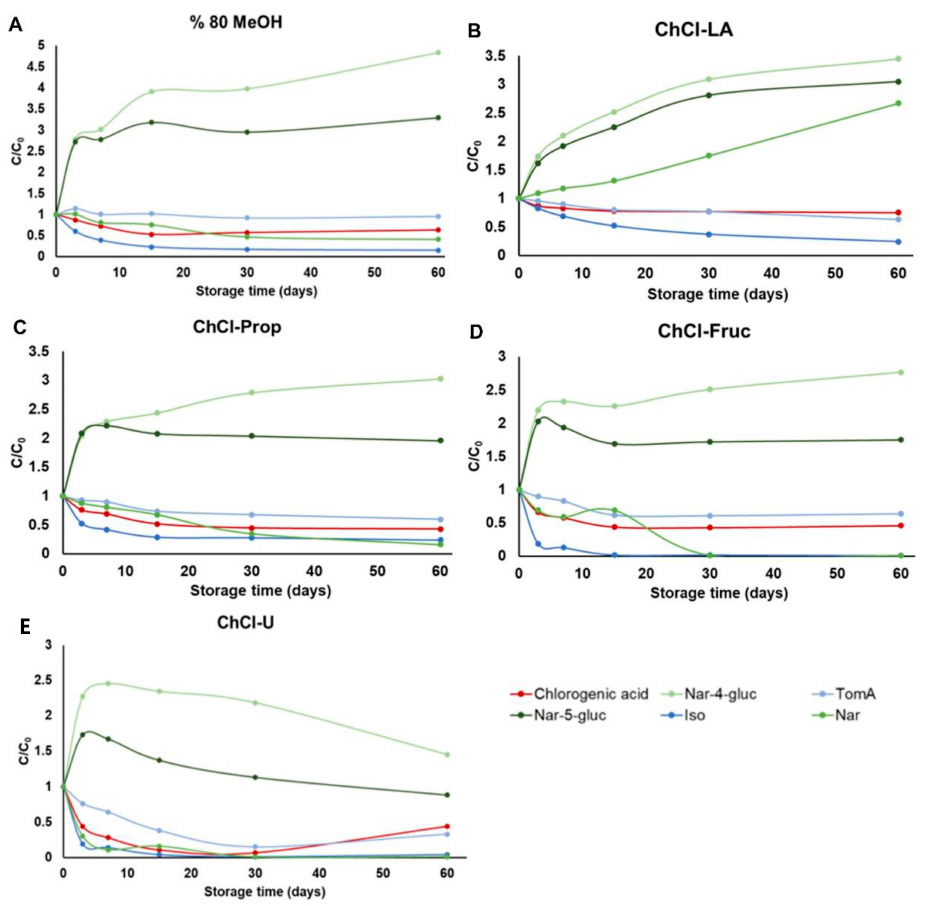
Figure 5. Stability of the selected phenolic compounds extracted from H. arenarium with five different solvents ( A ) 80% MeOH, ( B ) choline chloride–lactic acid (1:2) NADES, ( C ) choline chloride:1,2- propanediol (1:2) NADES, ( D ) choline chloride:fructose:water (2:1:1) NADES and ( E ) choline chlo- ride:urea (1:2) NADES), over a period of 0 to 60 days, stored, stored at 25 ◦